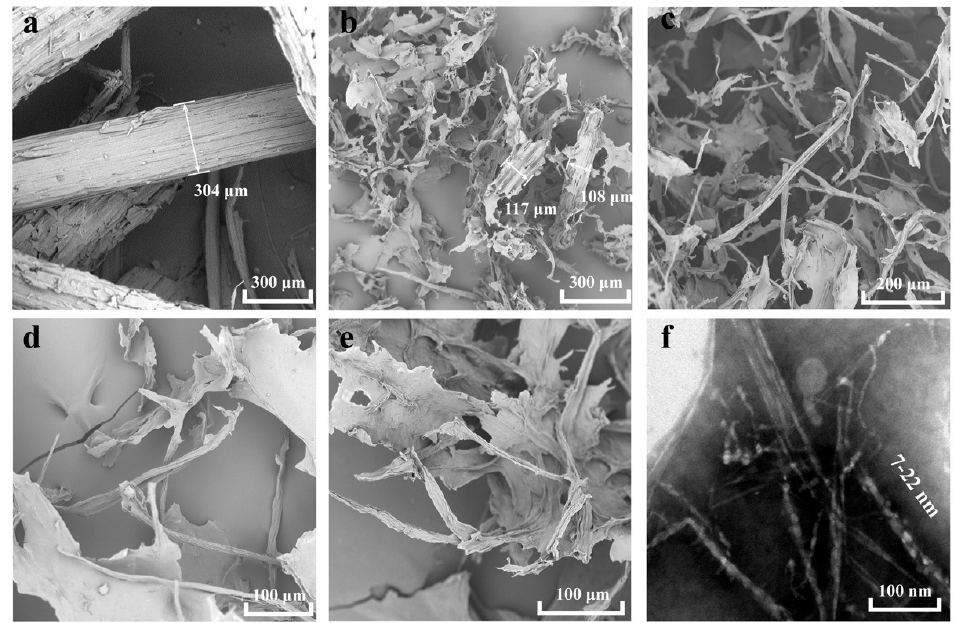
Figure 3. ( a ) Untreated bagasse fiber; ( b – e ) scanning electron microscope (SEM) images of bagasse treated with H 3 PO 4 and H 2 O 2 for 2, 6, 12, and 24 h, respectively (arrow length: fiber width); and ( f ) transmission electron microscopy (TEM) images of bagasse treated with H 3 PO 4 and H 2 O 2 for 24 h. Nanomaterials 2020 , 10 , x FOR PEER REVIEW